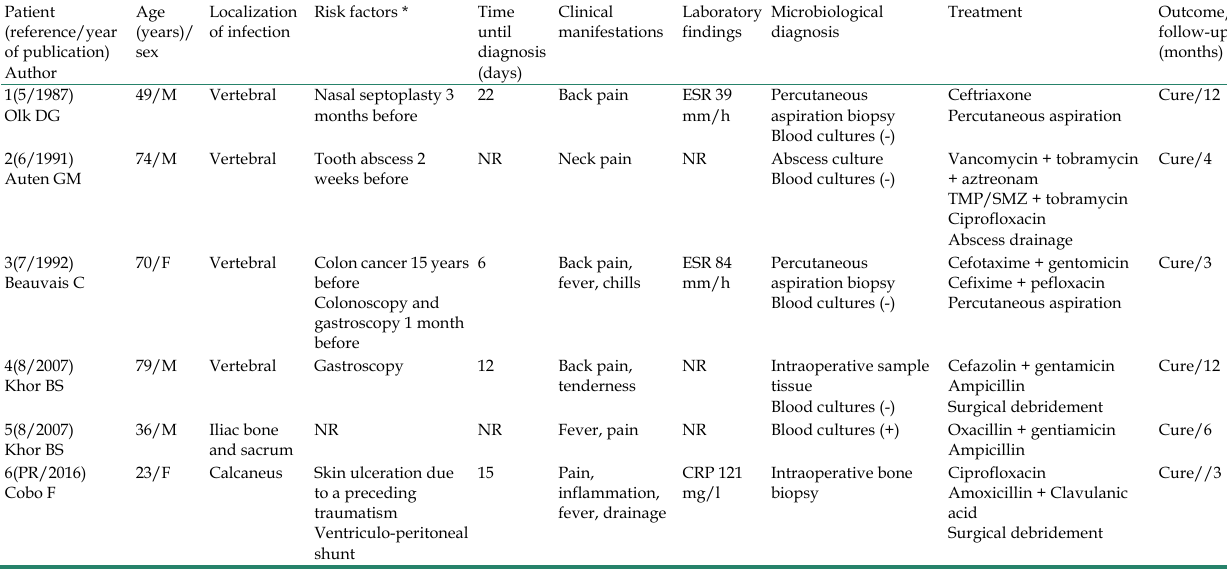
Table 1. Main findings in 6 patients with osteomyelitis caused by Haemophilus parainfluenzae . Patient